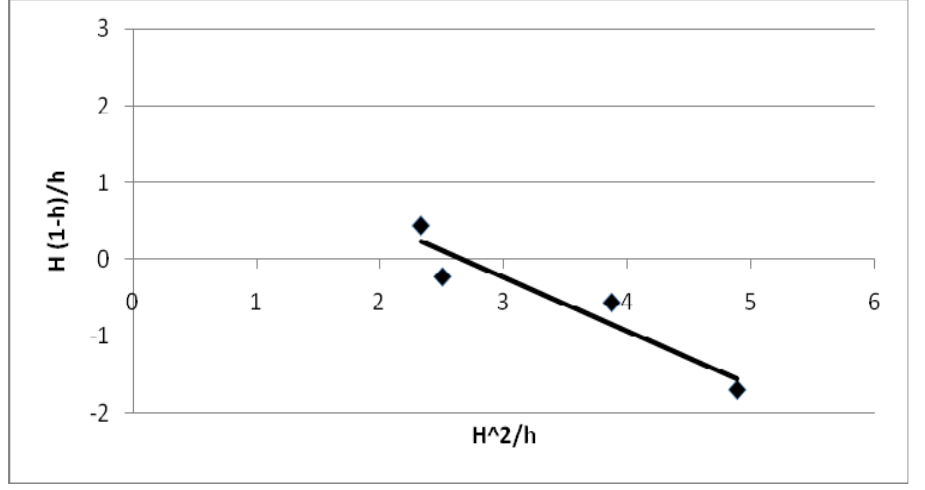
/h plot for reactivity ratio determination of